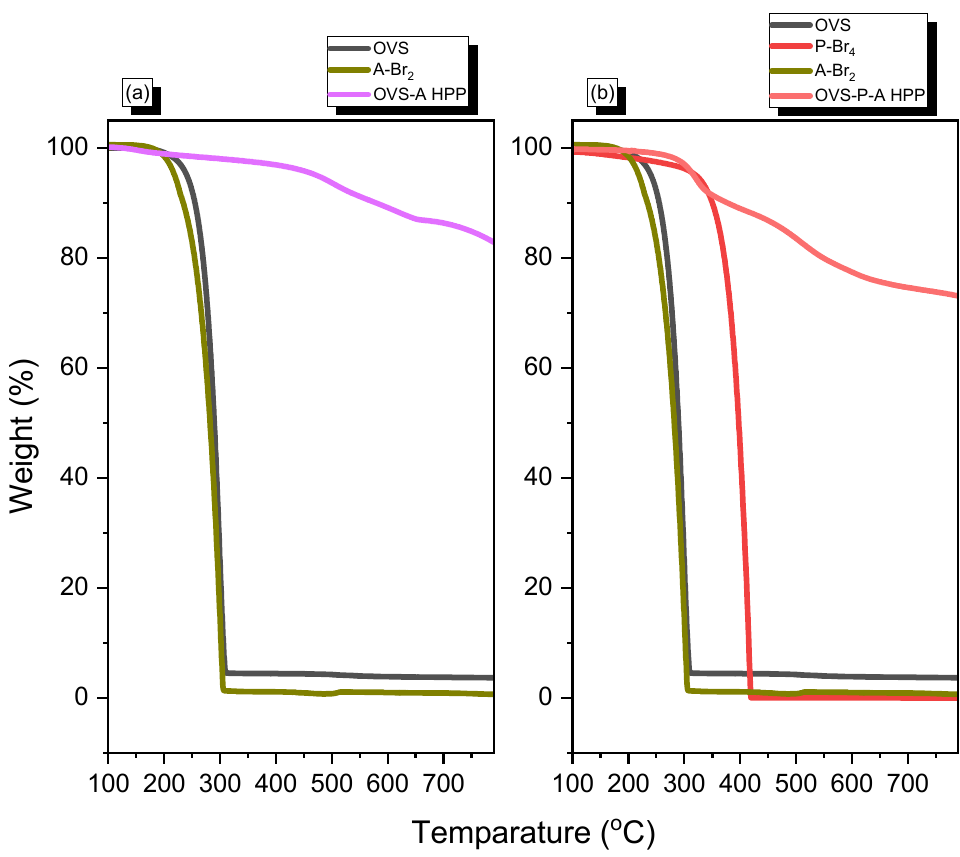
Figure 3. TGA analysis of ( a ) OVS, A-Br 2 , OVS-A HPP and ( b ) OVS, P-Br 4 , A-Br 2 , OVS-P-A HPP. Table 1. Thermal stability, porosity, and electrochemical performance of OVS-A HPP and OVS-P-A HPP .